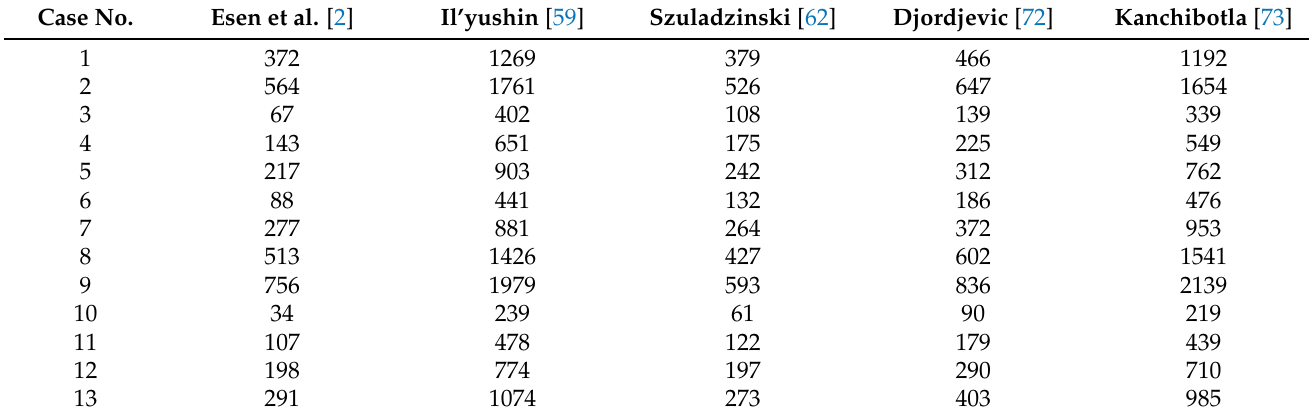
Table 6. Results of the selected methods in estimating damage radius for the 13 studied samples. Case